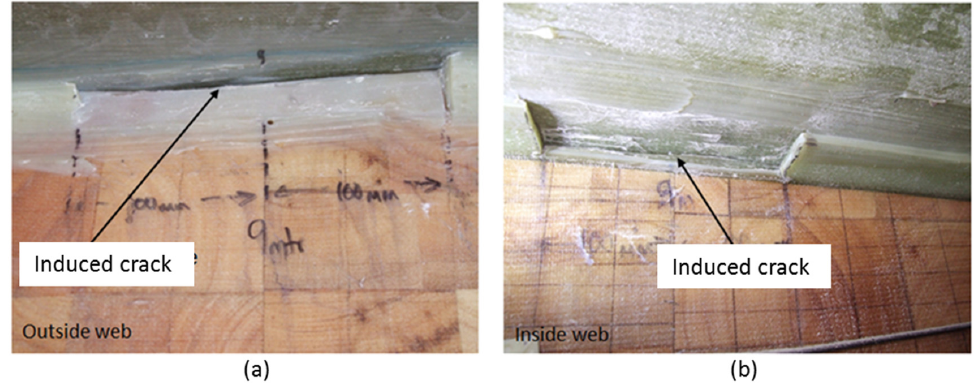
Figure 6. Creating a 200 mm crack at 9 m from the root. View from ( a ) outside and ( b ) inside of the shear web box.